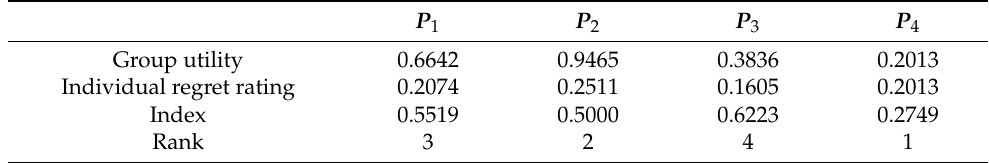
Table 8. Group utility, individual regret rating, index, and rank of each project.